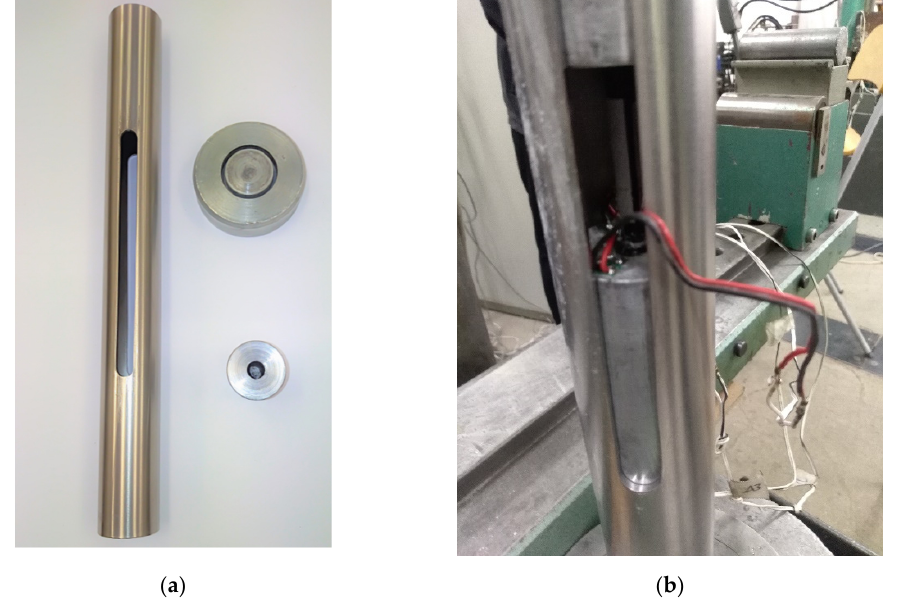
Figure 7. Testing device: ( a ) Components in the bar compression test; ( b ) openings on the lateral surface of the centering tube.